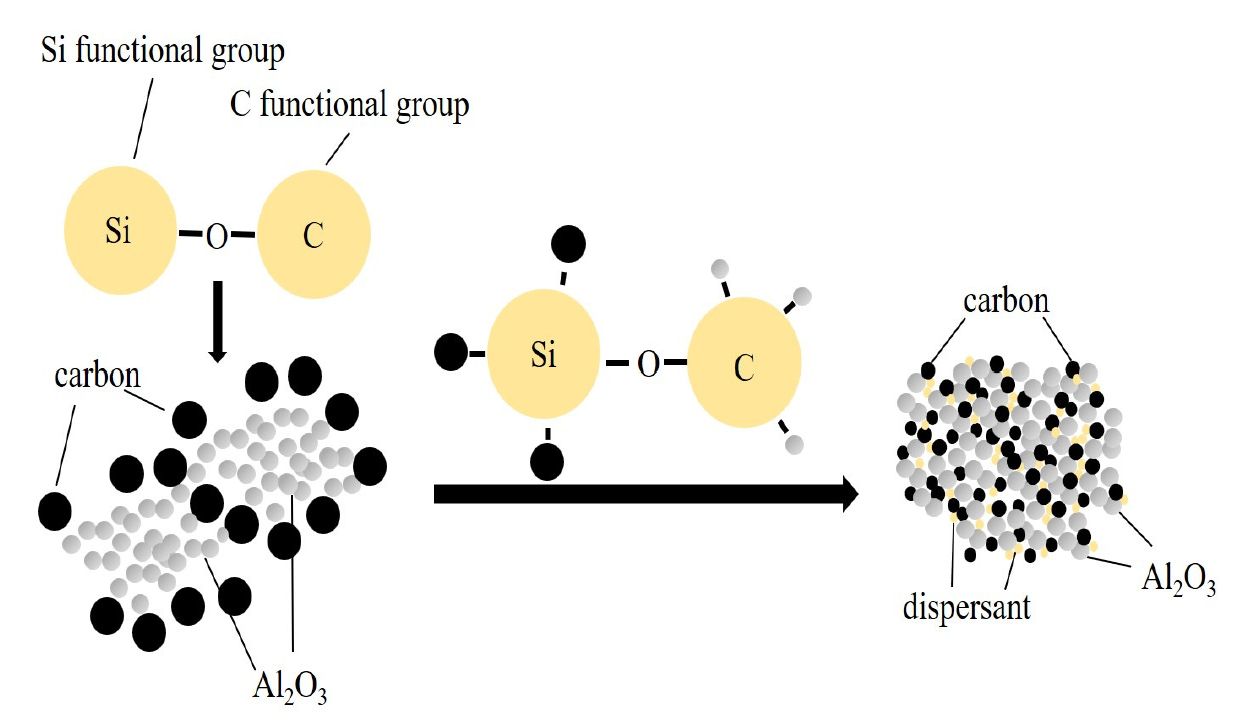
Figure 4. Schematic diagram of the interaction between dispersant and raw powder.